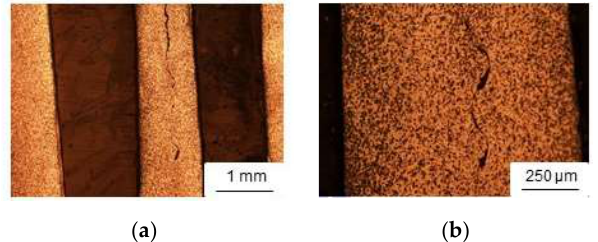
Figure 7. Metallographic images of the longitudinal cross-section of UniPore specimen. ( a ) lower magnification; ( b ) higher magnification.